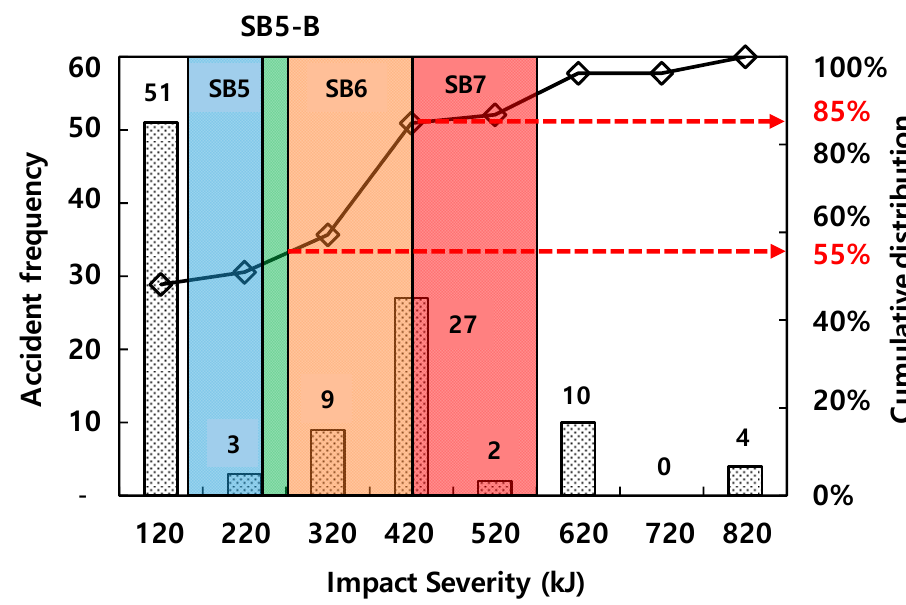
Figure 1. Accident frequencies depending on various impact severities [3].